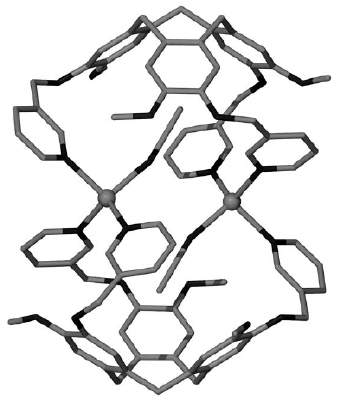
Figure 117. Structure of [Ag 2 (tris(3-pyamino)CTG) 2 (MeCN) 2 ] + cation. Reproduced with permission from reference [108]. Copyright © (2006) John Wiley &